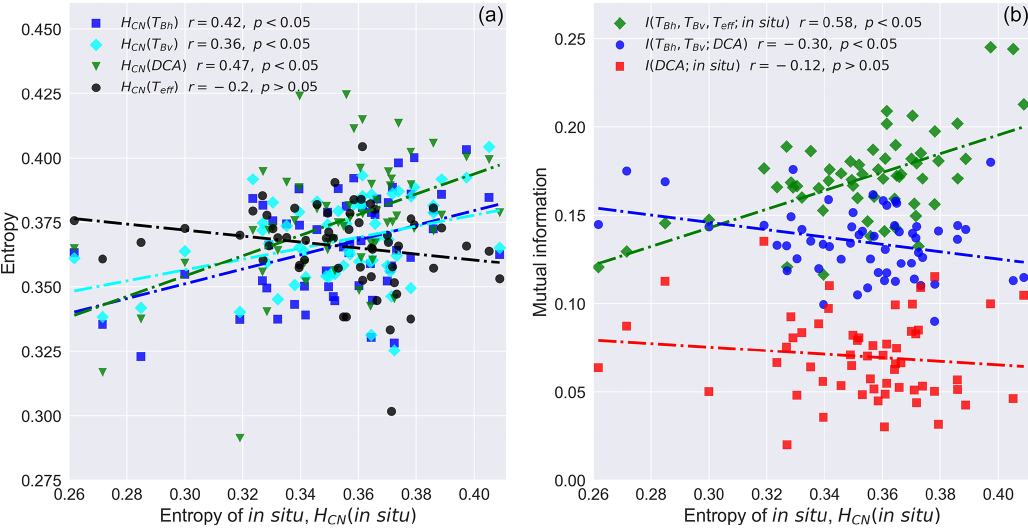
Figure 4. Entropy of in situ soil moisture against the entropies of DCA soil moisture, horizontally polarized brightness temperature ( T Bh ), vertically polarized brightness temperature ( T Bv ), and soil effective temperature ( T eff ) (a) and mutual information quantities (b) . Table 1. The number of informational uncertainties in percentage. The values in the table are the average of each land cover. The values in “Overall” are the averages of all the sites. The “Lumped” field is computed using all available datasets. Land cover Informational random Informational model Informational total Number of uncertainty, I Rnd uncertainty, I Mod uncertainty, I Tot Sites (and its % of I Tot ) (and its % of I Tot ) (and its % of H CN ( in situ ) ) Shrublands 0.21 (68%) 0.10